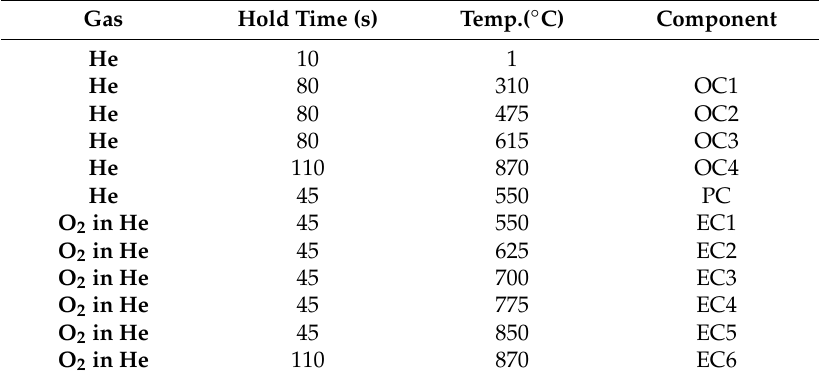
Table 1. Detailed parameters for the thermal / optical analytical protocol for the carbonaceous compounds. Gas Hold Time (s) Temp.( ◦ C) Component He 10 1 He 80 310 OC1 He 80 475 OC2 He 80 615 OC3 He 110 870 OC4